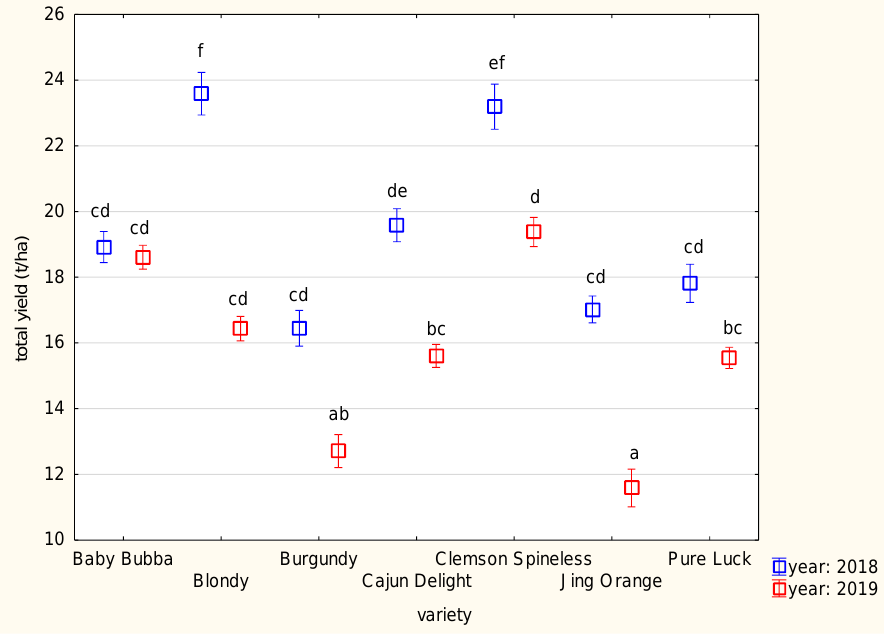
Figure 3. Yield of okra fruits per hectare by Scheffe test (error bars represent SD; different letters among cultivars and years show statistically significant differences at the level p < 0.05).